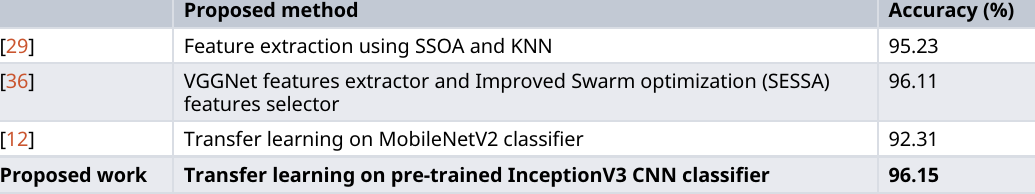
Table 4. Comparisons between previous works and proposed